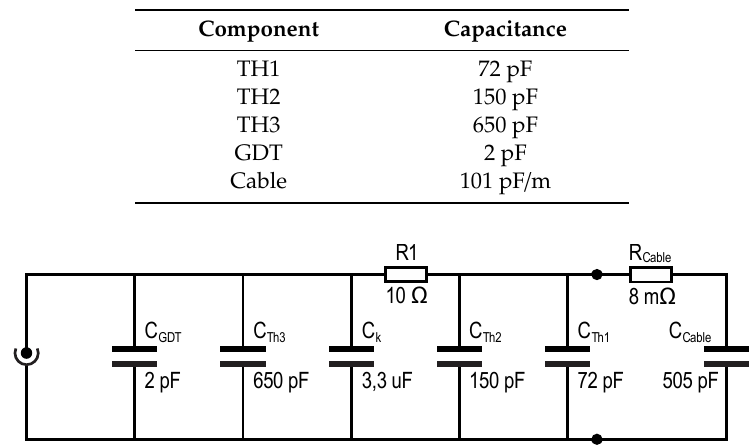
Figure 7. Internal circuit of the coupling device with equivalent representations of the protective elements and cable.